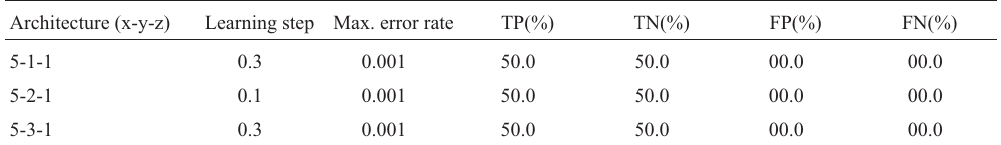
Table5 -Comparisonbetweenthesecondmodelnetworks.ThecolumnArchitecture(x-y-z)indicatesthenumberofunitsintheinput,hidden,andoutput layers, respectively. Architecture (x-y-z)